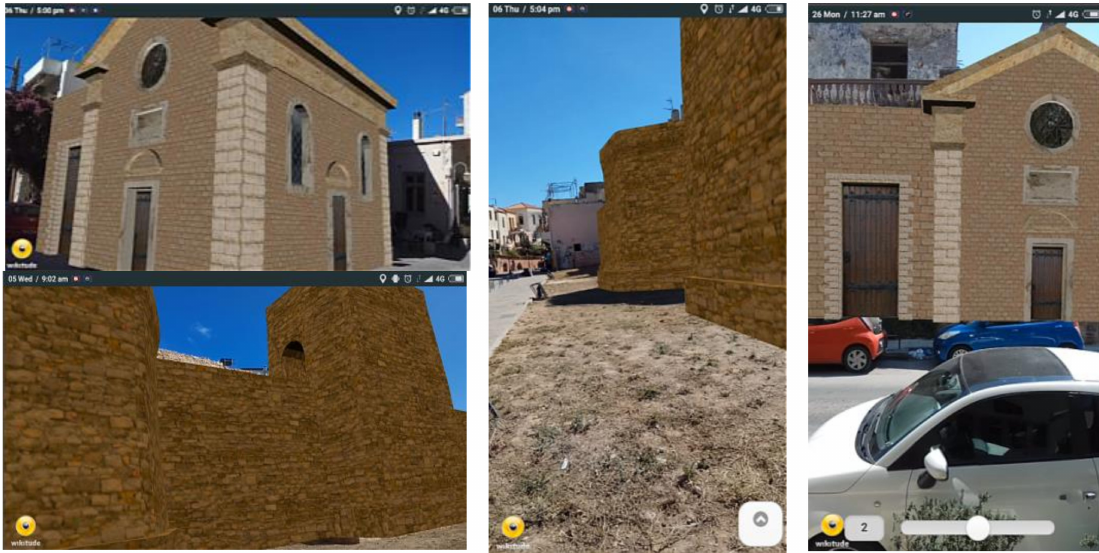
Figure 14. 3D depictions of the demolished towers of the Byzantine wall and the facial restoration of the Rocco